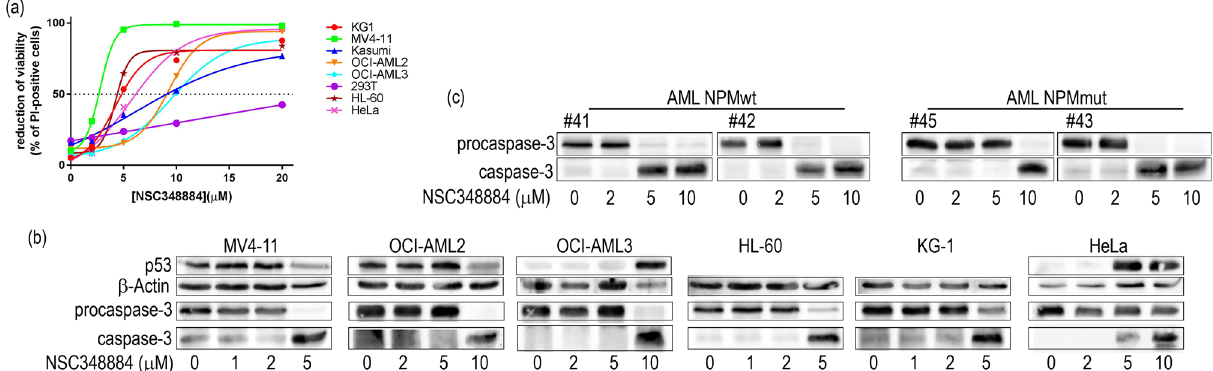
Figure 7. The effect of 24 h NSC348884-treatment on cell viability and apoptosis. ( a ) Cell viability monitored by propidium iodide exclusion: each point represents the mean value of 3–10 independent experiments. ( b , c ) Representative blots of caspase-3 fragmentation and p53 expression in cell lines ( b ) and in primary AML cells ( c ). β-Actin levels serve as a loading control.